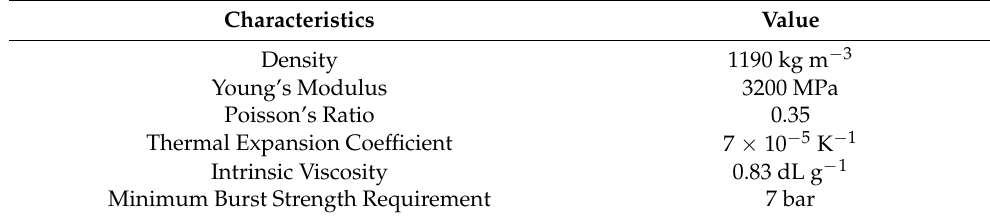
Table 2. Characteristics and test indexes of